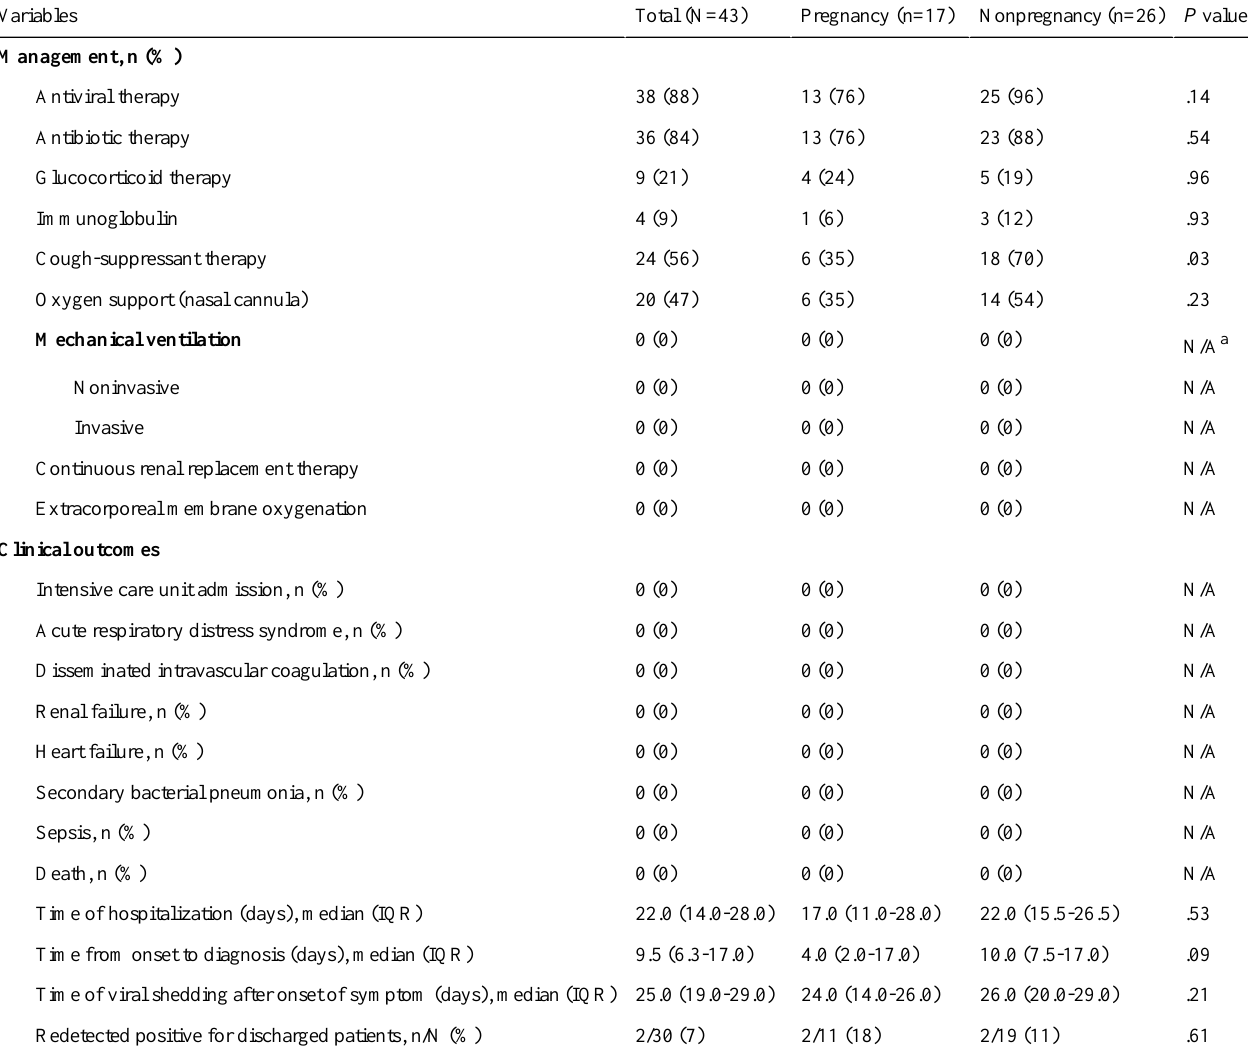
Table 3. Clinical treatment and outcomes of pregnant and nonpregnant women with the coronavirus